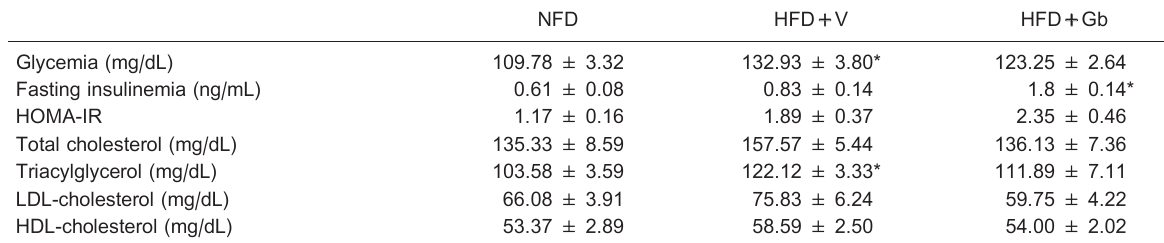
Table 2. Glycemia, plasma insulin levels, and HOMA-IR of NFD (n=8-13), HFD++V (n=13), and HFD++Gb (n=8-13) groups and blood lipid profile of NFD (n=8), HFD++V (n=9), and HFD++Gb (n=5) groups. NFD HFD++V Glycemia